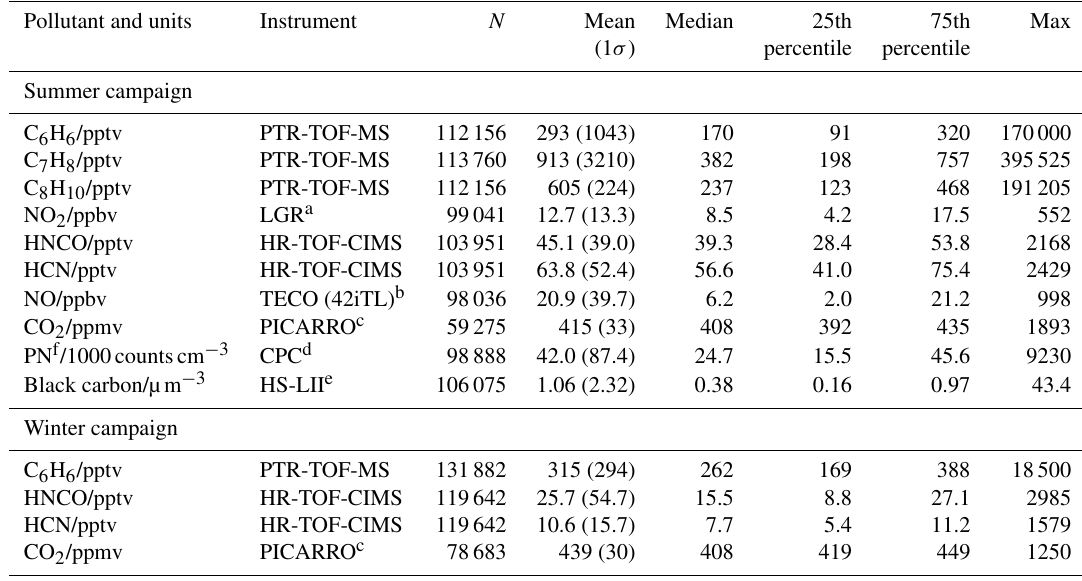
Table 1. Method of detection and ambient concentration statistics for selected pollutants on CRUISER. Pollutant and